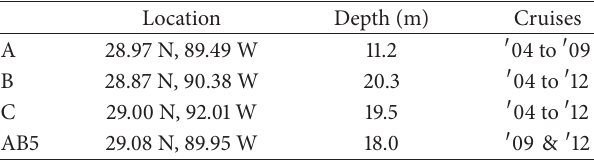
Table 1: Sampling locations and depths of each site.